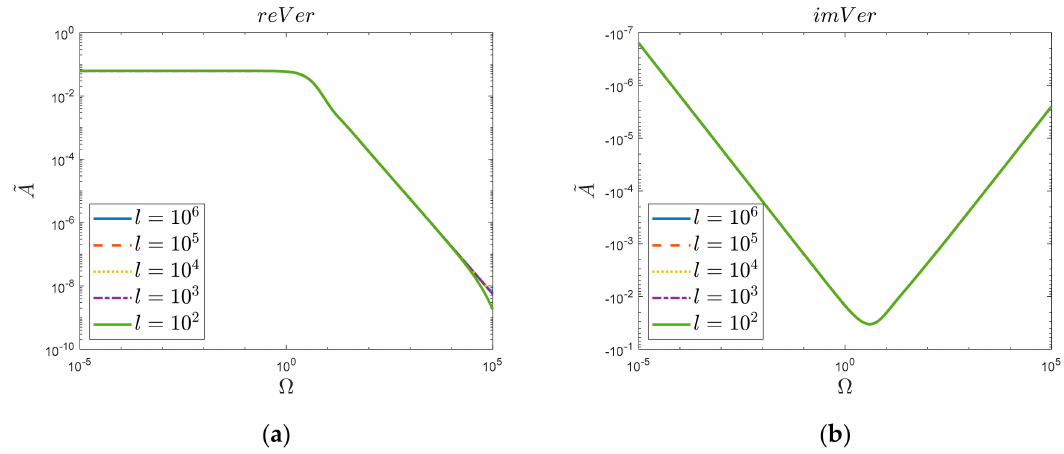
Figure 5. Dependence on the number of summation terms “ l ” of newly derived function: ( a ) Realis, ( b )